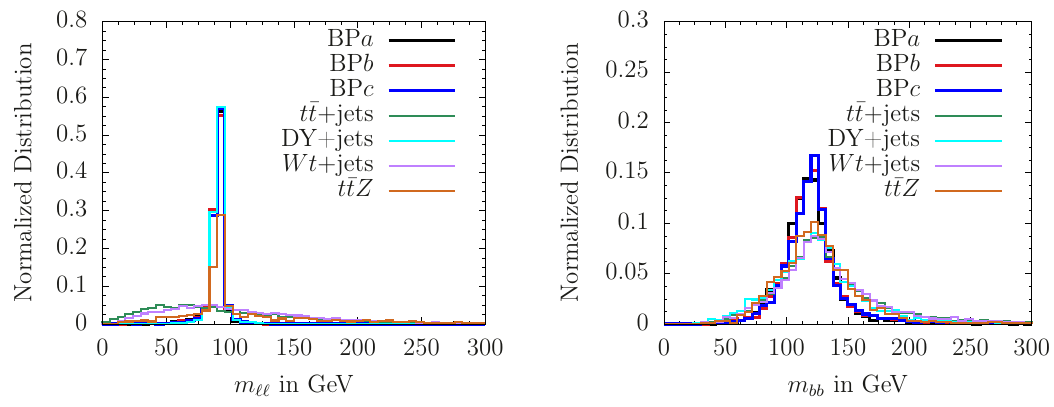
Figure 5 . The normalized m ‘‘ (left) and m bb (right) distributions of the three BPs and leading backgrounds for the bZh